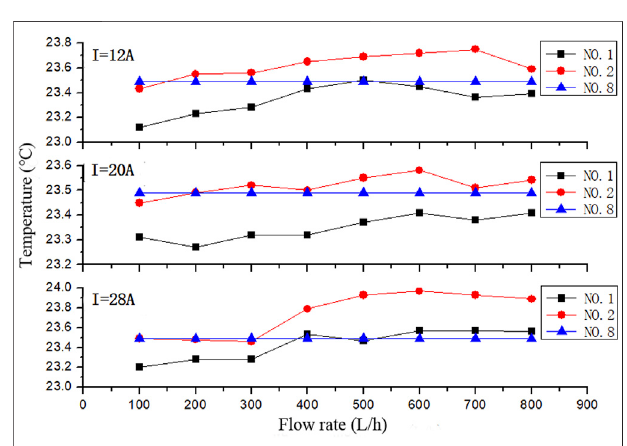
FIGURE 5 | Air fl ow temperatures at different